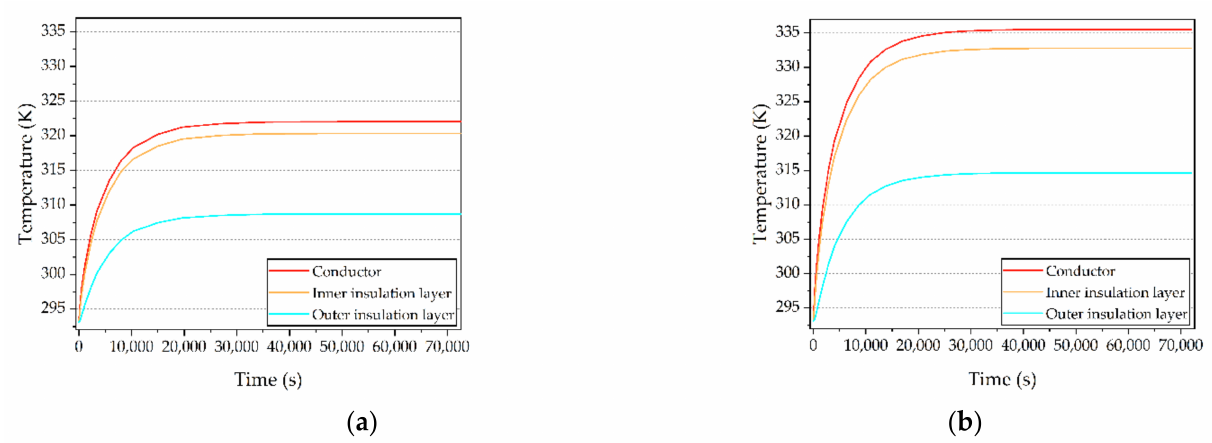
Figure 4. Time-varying temperatures in the conductor, inner insulation layer and outer insulation layer, with applied load currents: ( a ) 800 A; ( b ) 1000